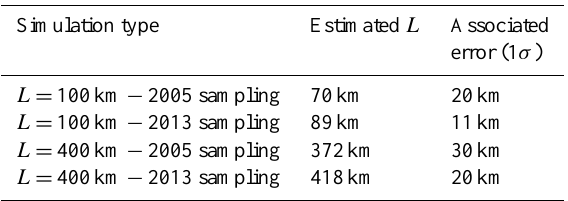
Table 1. Simulation of the impact of Argo sampling on the estima- tion of correlation functions.